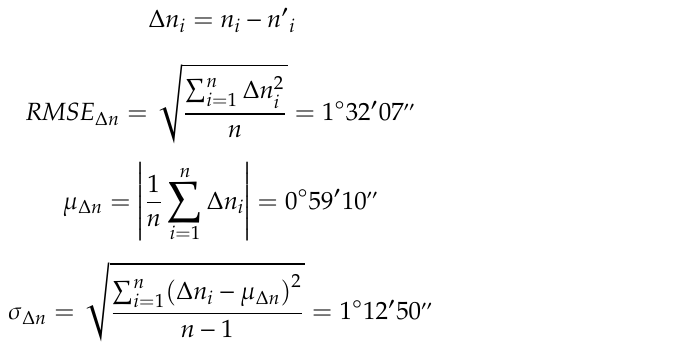
Figure 19. Presentation of inclinations of reference (black line) and proposed GPR-TPS model (red line). ( a ) black line: − 0.9% inclination, 𝑟 (cid:2870) = 0.78 , red line: − 2.5% inclination, 𝑟 (cid:2870) = 0.52 of target object No. 1 ( 𝑅𝑀𝑆𝐸 ∆(cid:3035) = 0.078 m, 𝜇 ∆(cid:3035) = 0.015 m, 𝜎 ∆(cid:3035) = 0.081 m); ( b ) black line: − 5.1% inclination, 𝑟 (cid:2870) = 0.99 , red line: − 4.7% inclination, 𝑟 (cid:2870) = 0.25 of target object No. 10 ( 𝑅𝑀𝑆𝐸 ∆(cid:3035) = 0.082 m, 𝜇 ∆(cid:3035) = 0.031